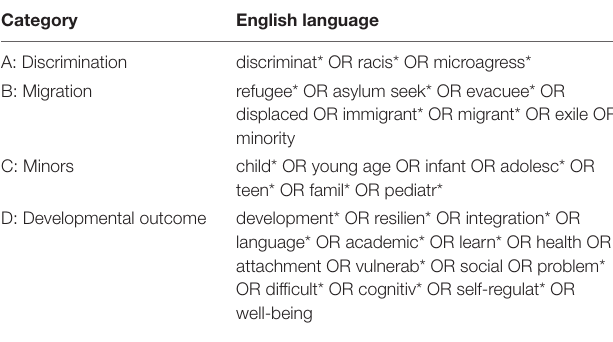
TABLE 2 | Terms used in systematic database literature